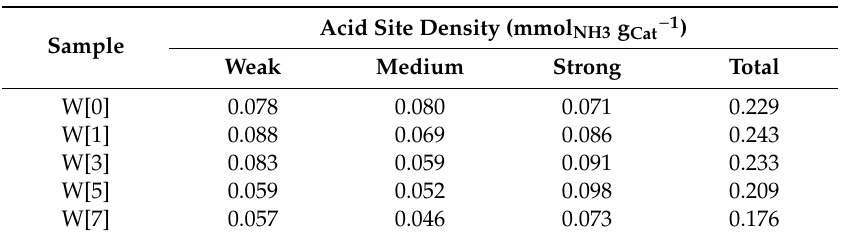
Table 4. Density of acid sites on Pt–W[x] / TiO 2 catalysts as determined by NH 3 -TPD analysis. Sample